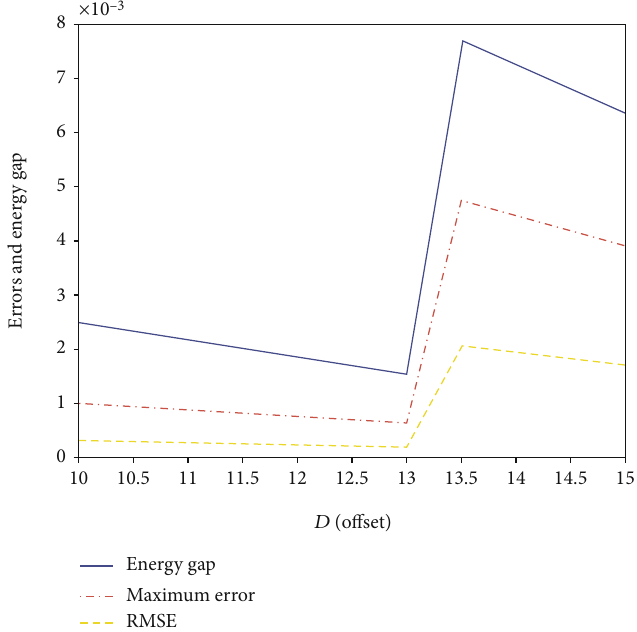
Figure 1: Determining the optimal o ff set in the MFS by minimizing the energy gap for Example 2.